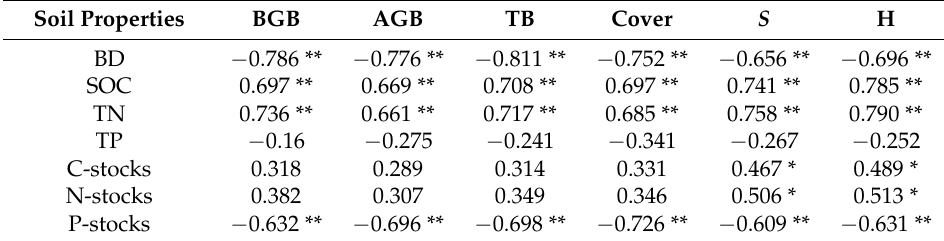
Table 2. The Pearson relationships between soil properties and plant characteristics.